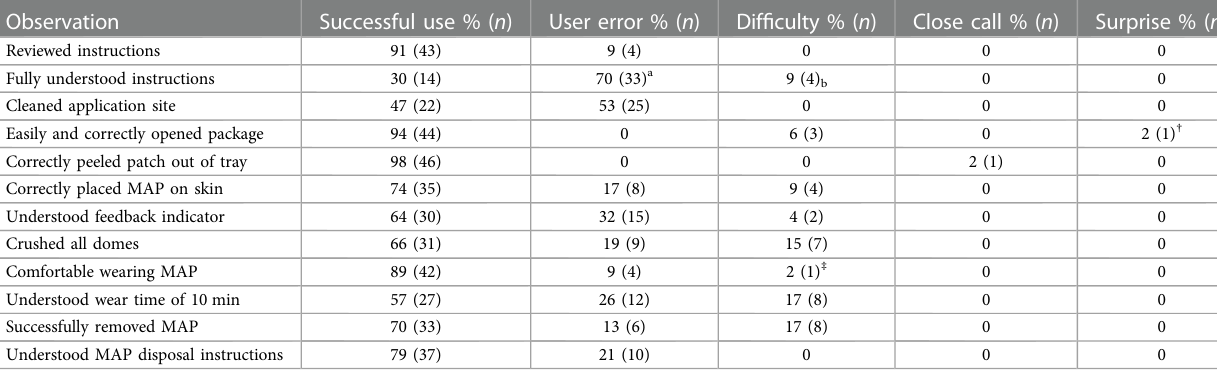
TABLE 3 Summary scores of mock exercise observations for all user groups ( n =47).